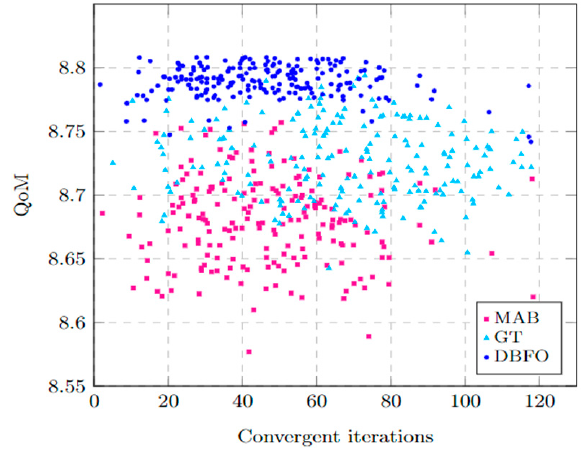
Figure 16. Iterative process of the three algorithms.